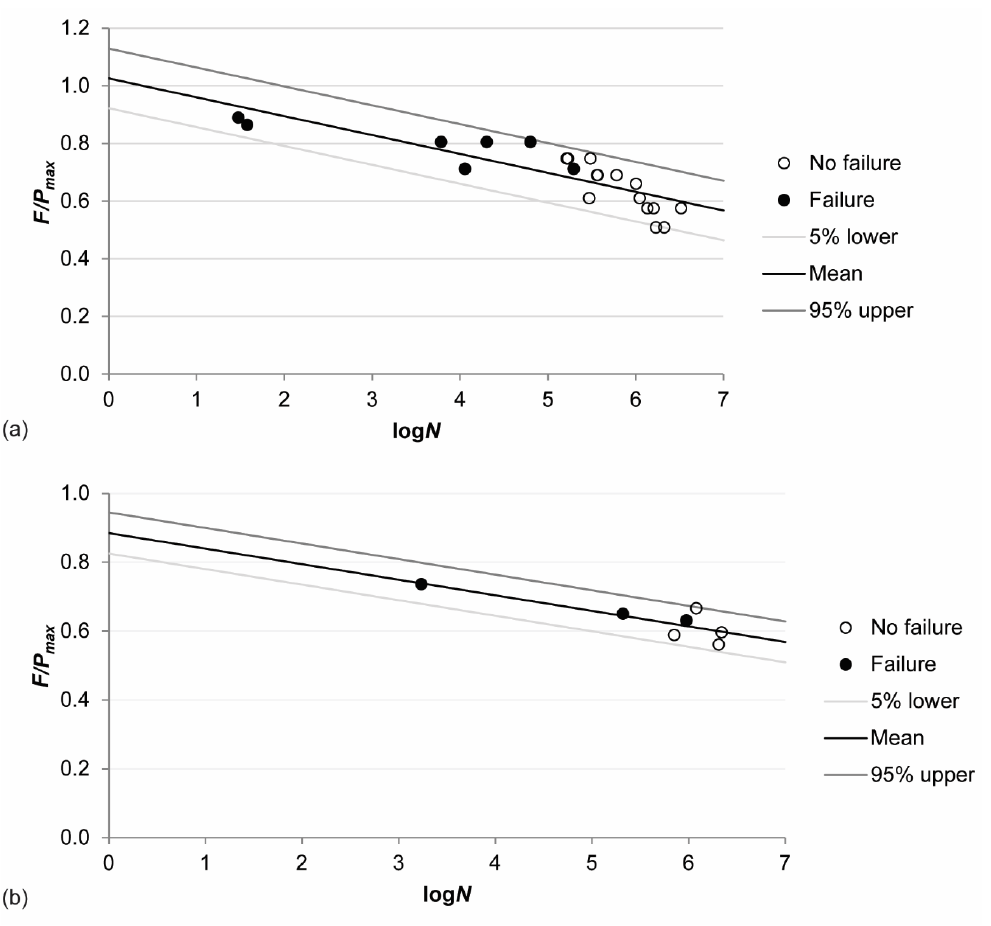
Figure 7. Relation between the number of cycles N and applied load level F / P max for ( a ) a single wheel load; and ( b ) a double wheel load, from Reference [37]. Reprinted with permission. This figure was originally published in Vol. 116 of the ACI Structural Journal.